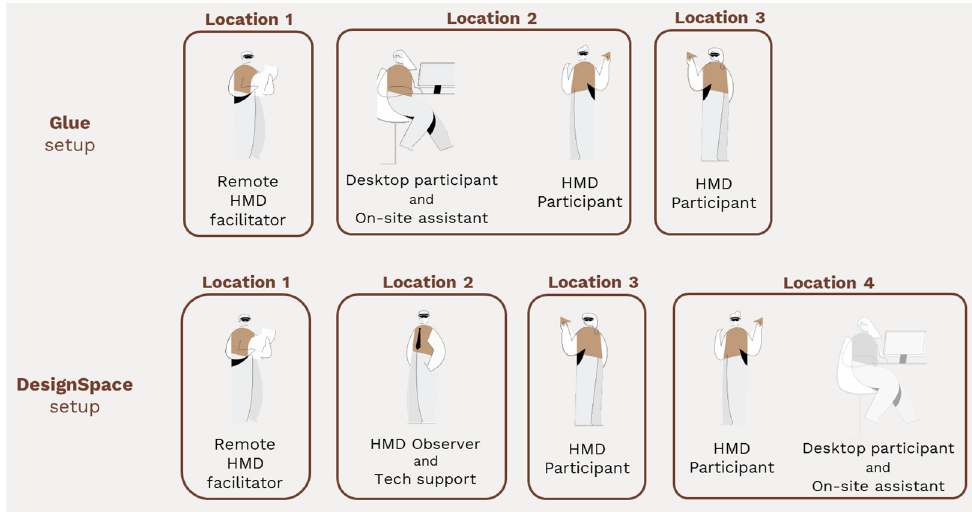
Figure 3. Different test setups used in Case 1. In DesignSpace sessions, one HMD participant joined alone from their location. The other HMD participant joined either alone or from the same location as the desktop participant, who acted as an on-site